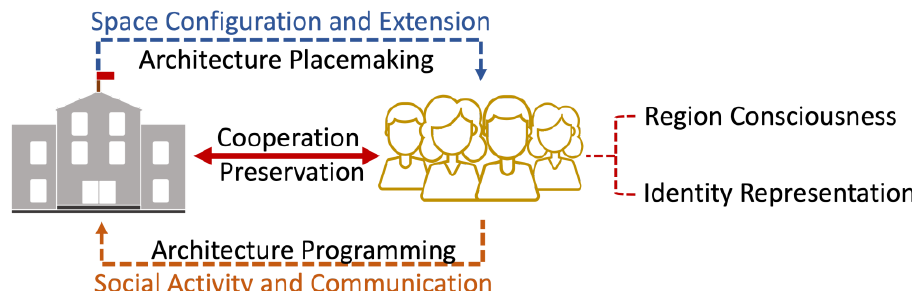
Figure 2. The Scope of the Research